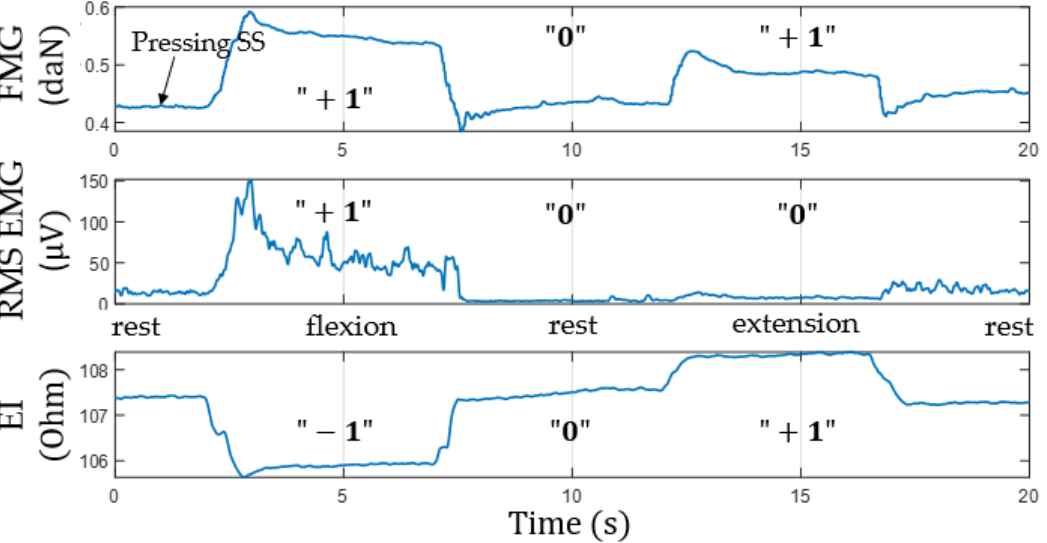
Figure 11. Simultaneous acquisition of EI, EMG, and FMG signals from extensor muscles during flexion/extension (“+1”, signal increase; “0”, no change; “ − 1”, signal decrease; SS, sensor system).